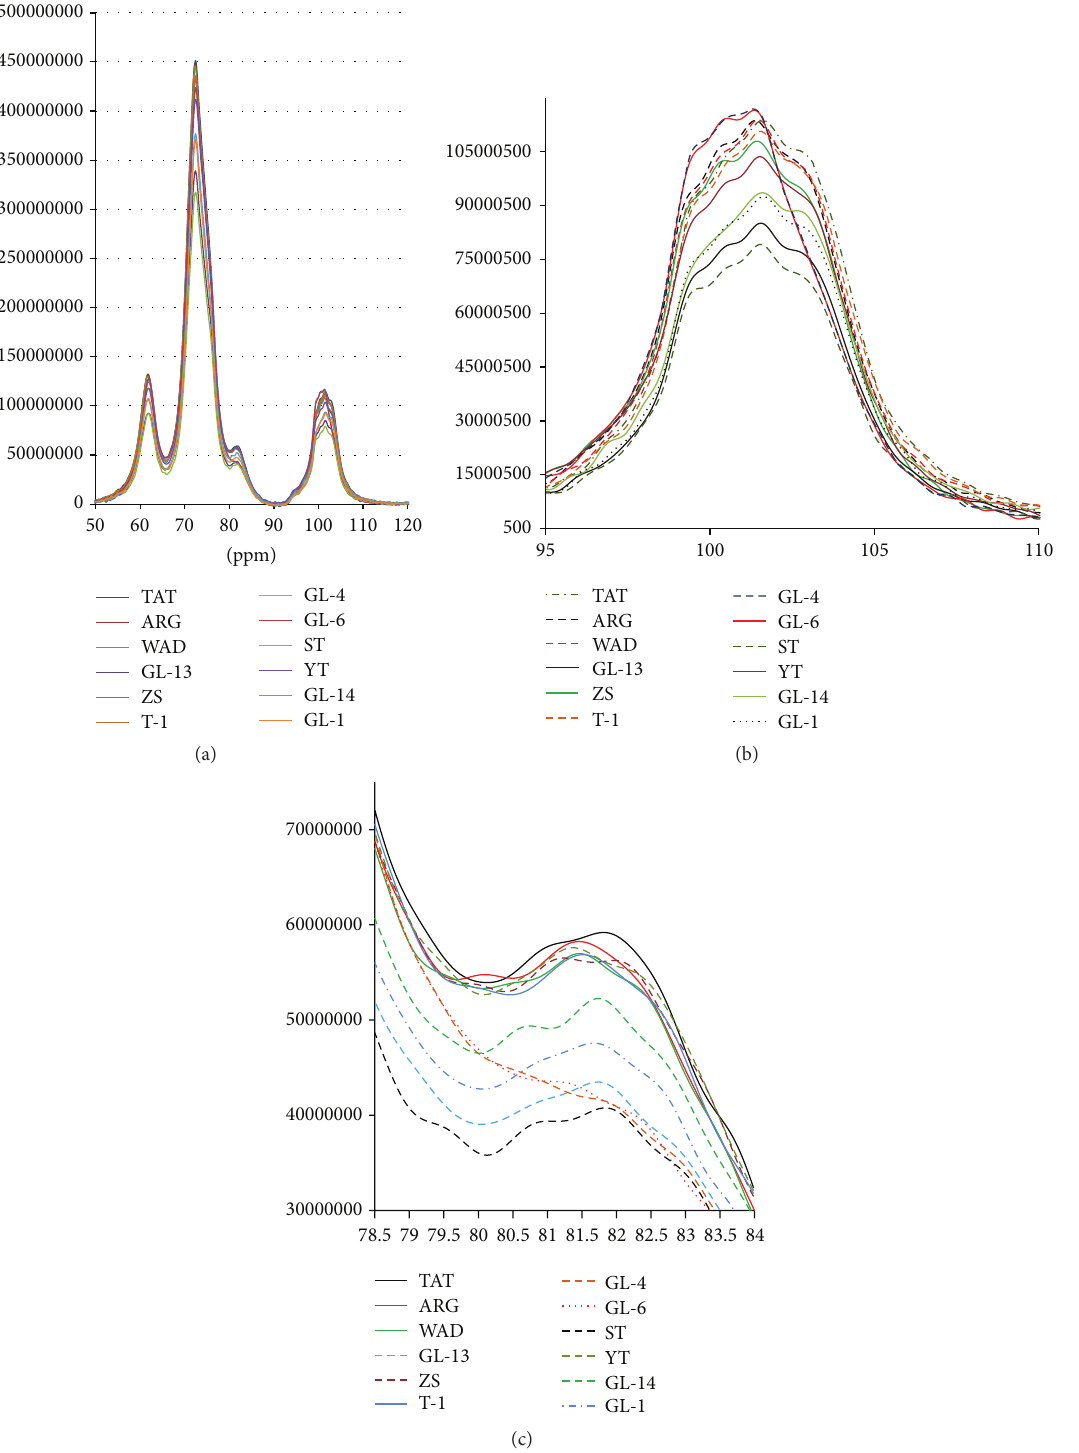
Figure 5: The 13 C CP/MAS NMR spectrograph (a) and C 1 resonance (b) and C 4 resonance (c) of starches from different sweet and grain sorghum